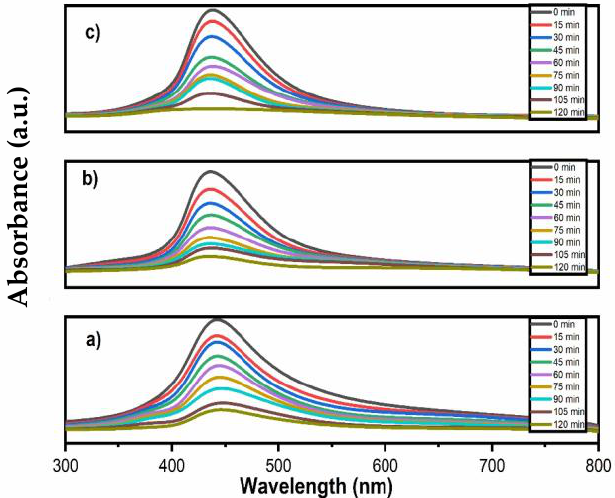
Figure 10. Photocatalyst dye degradation of ( a – c ) Sr-doped ZnSe nanoparticles against the MO dye spectrum.